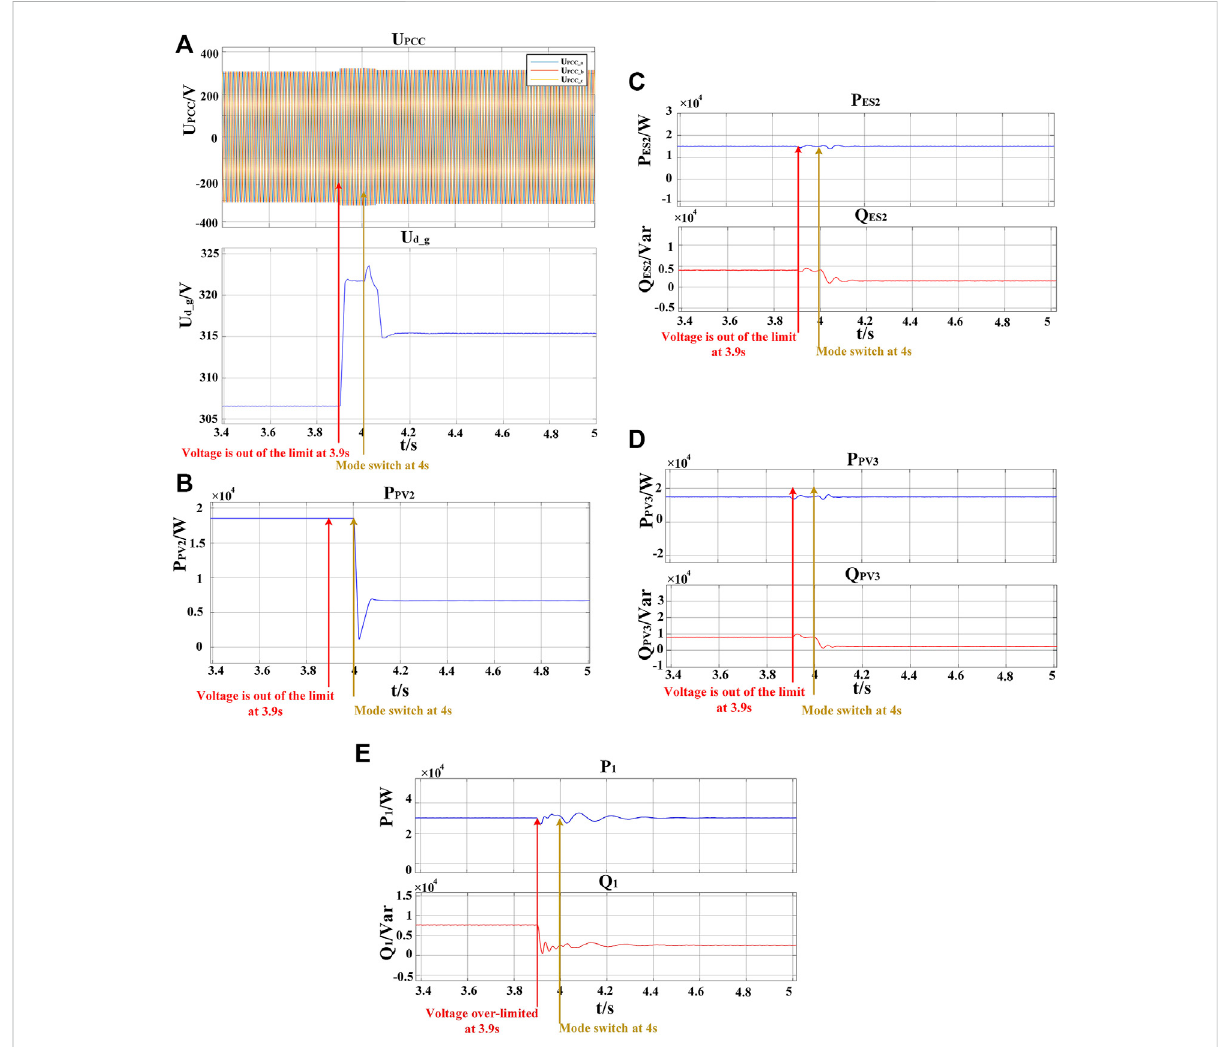
FIGURE 12 The output of the DGs in the prosumer during mode switch: (A) The voltage in PCC during mode switch; (B) The output active power of PV2 during mode switch; (C) The output active power and reactive power of ES2 during mode switch; (D) The output active power and reactive power of PV3 during mode switch; (E) The output active power and reactive power of the integrated inverter during mode